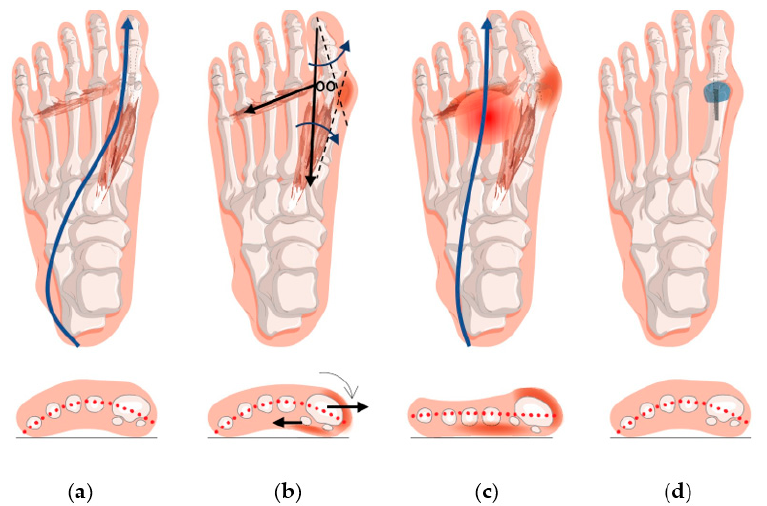
Figure 1. Pathomechanism of HV and transfer metatarsalgia: ( a ) The first ray plays an important role in push-off functions. The blue line illustrates the center of pressure trajectory during gait; ( b ) since the first metatarsal is less stable without any muscle insertions, it might deviate medially, conforming with the direction of the push-off load. The black arrows represent the directions of muscle force. The blue arrows represent the deformity directions of the bones [7]. The hallux and the sesamoids are hold in position by the muscle and plantar aponeurosis. Therefore, the hallux looks laterally deviated relative to the first metatarsal, while the sesamoids beneath the first metatarsal head are gradually exposed and disanchored. Plantarflexors, abductors, and stabilizing muscles of the first ray would become lateral to the longitudinal axis of the first ray and distribute deforming forces [7]. The problem aggravates with higher exposure and loading of the forefoot, such as wearing high-heeled shoes [26]; ( c ) when the muscles and the sesamoids that served as the fulcrum are deranged, the load-carrying capability and push-off functions are compromised and compensated by other forefoot regions, resulting in transfer metatarsalgia. The blue line represents the lateralized center of pressure trajectory; ( d ) the bone alignment and sesamoid positions shall be corrected after HV surgeries, but whether the center or pressure trajectory and thus load-carrying capability of the first ray could be restored is in doubt.